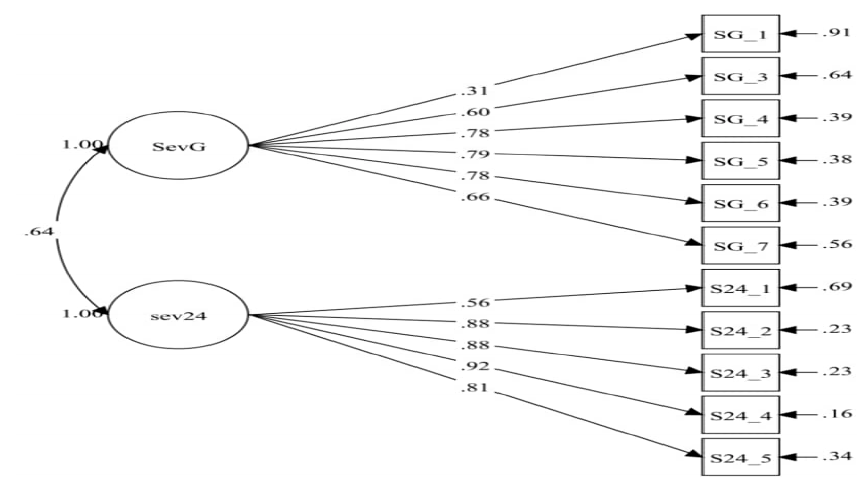
Figure 1. Model of severity in the Bloating Severity Questionnaire in the Malay language (BSQ-M) consisting of two domains (sevg = severity general and sev24 hrs = severity 24 h). SG_1 = SEVG1, SG_3 = SEVG3, SG_4 = SEVG4, SG_5 = SEVG5, SG_6 = SEVG6, SG_7 = SEVG7, S24_1 = SEV241, S24_2 = SEV242, S24_3 = SEV243, S24_4 = SEV244, S24_5 = SEV245.